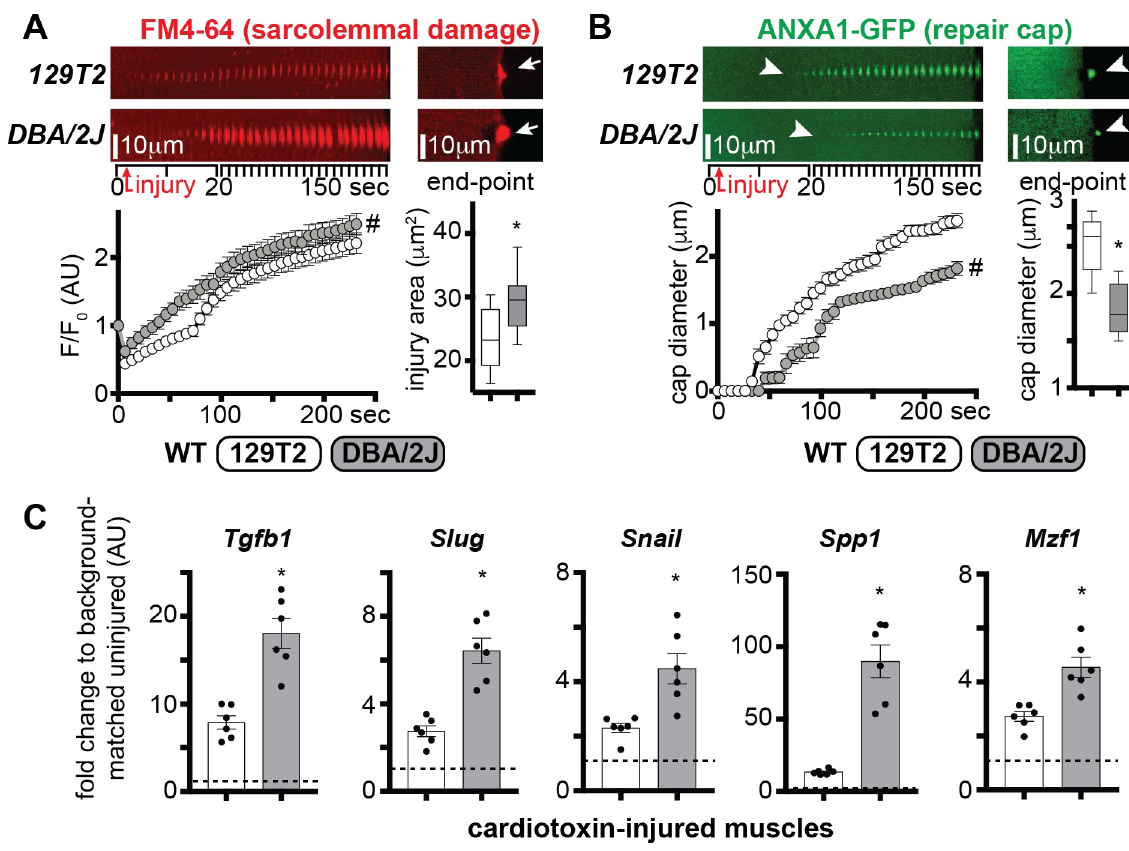
Fig 6. The DBA/2J genetic background is associated with increased sarcolemmal damage and higher levels of OPN and TGF β pathway genes. The DBA/2J background exacerbates the muscular dystrophy phenotype [6, 9]. A) The extent of sarcolemmal damagewas significantly higherin WT DBA/2J myofibers, as comparedto age-matched WT 129T2 myofibers, both over time and at end-point(arrows). B) Repair cap formation, monitoredby GFP-tagged ANXA1, appearedsignificantly delayedin DBA/2J myofibers (arrowheads), with a smaller cap diameterat end-point(arrowheads). The time series shows stacked consecutive images of the injuredsite at 10˚ orientation to reveal the extent of dye accumulation or repair cap formation. FM4-64 (red) and ANXA1-GFP (green)pictures were acquiredsimultaneously. C) qPCR analysisof cardiotoxin-injured tibialisanterior muscle tissue at 3 days post-injuryfrom 129T2 and DBA/2J mice versus strain-matched uninjuredlittermates showedthat